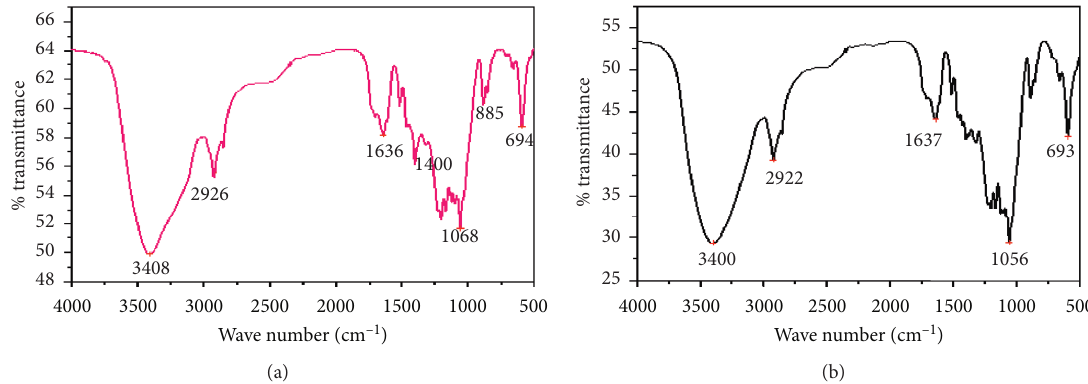
Figure 9: FTIR spectrum of the ethanol yield for untreated acid of stalk residues of sweet sorghum. (a) Chiquere variety; (b) Gebabe